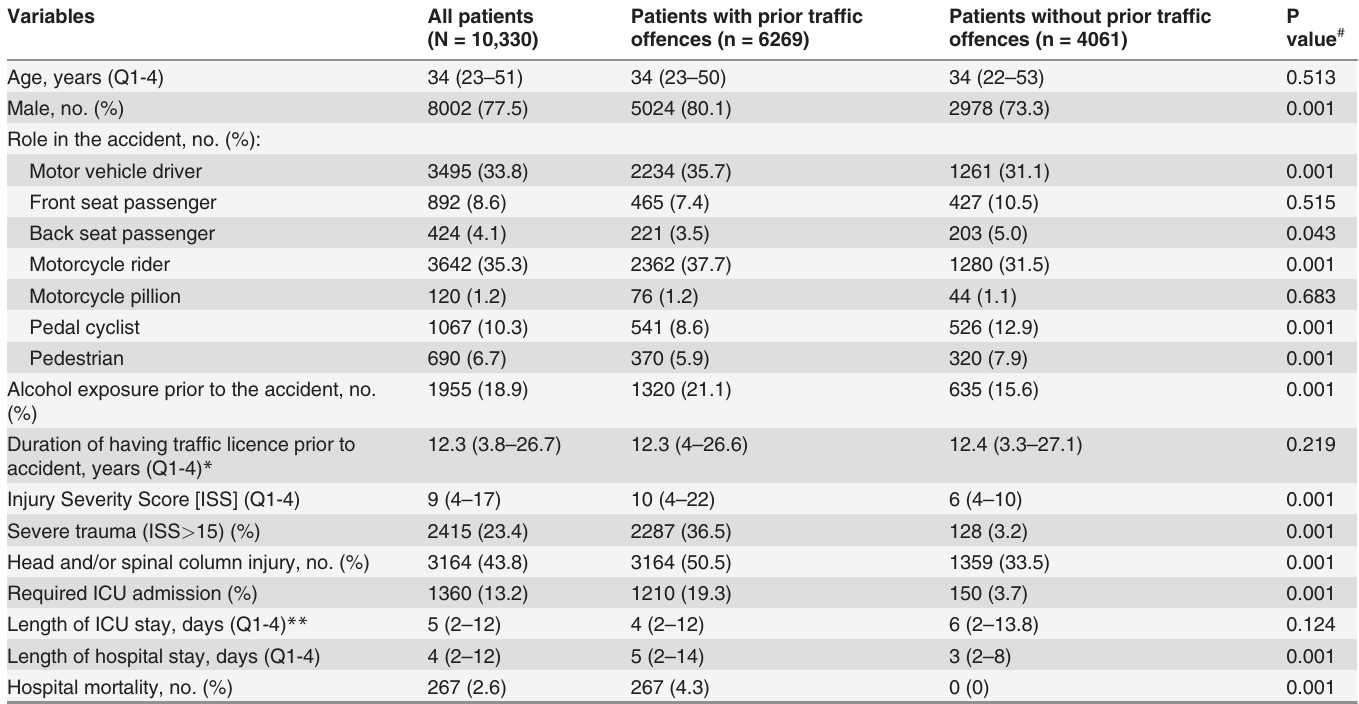
Table 1. Differences in characteristics and outcomes between those with and without prior traffic offences (N =